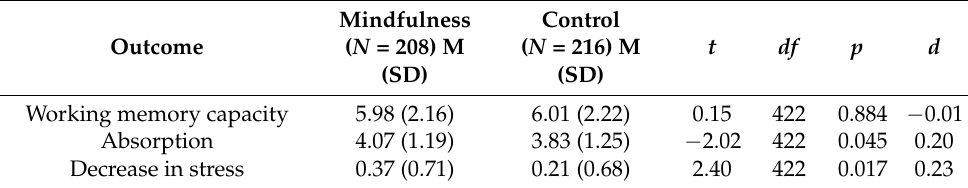
Table 4. Summary of Outcomes in Study 2.